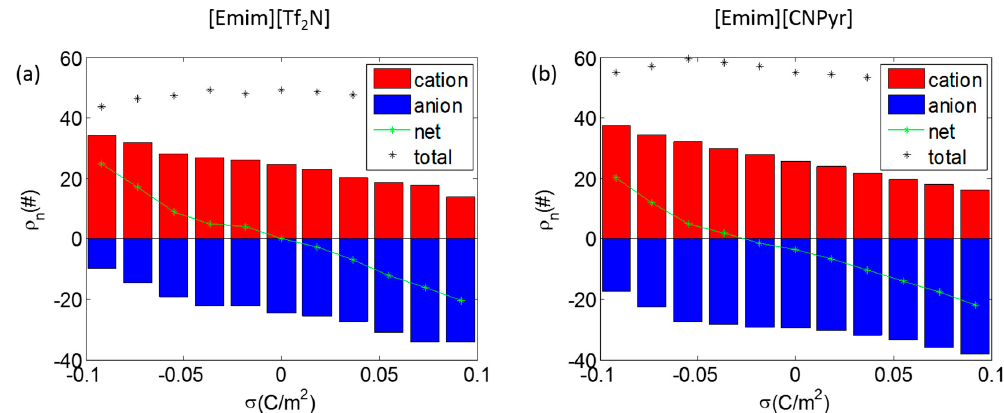
Figure 8. The number of ions within the first layer of EDLs for the [Emim][Tf 2 N] ( a ) and [Emim][CNPyr] ( b ) near positively-charged electrodes and negatively-charged electrodes at 350 K.